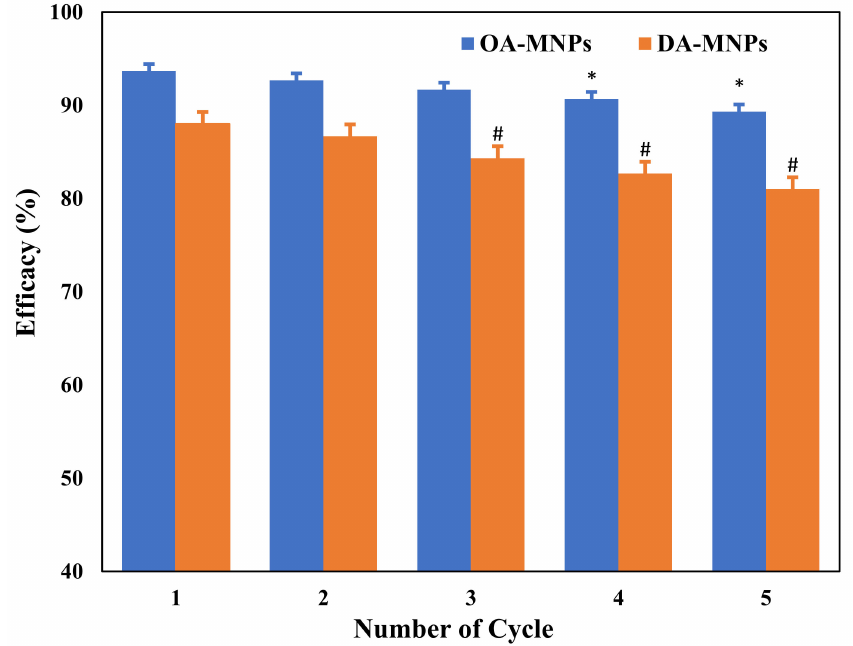
Figure 9. Reusability comparison of OA-MNPs and DA-MNPs. All data represented as mean ± , SD; * p < 0.05 against first cycle value; # p < 0.05 against first cycle